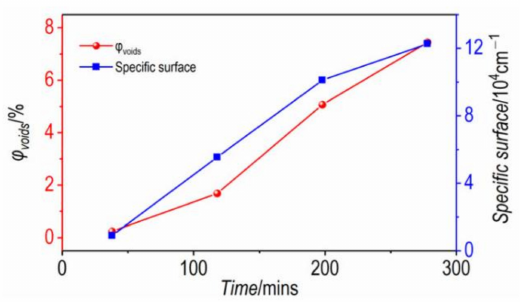
Figure 8. Pore volume fraction and specific surface of CL-20 over time at 200 ◦ C.